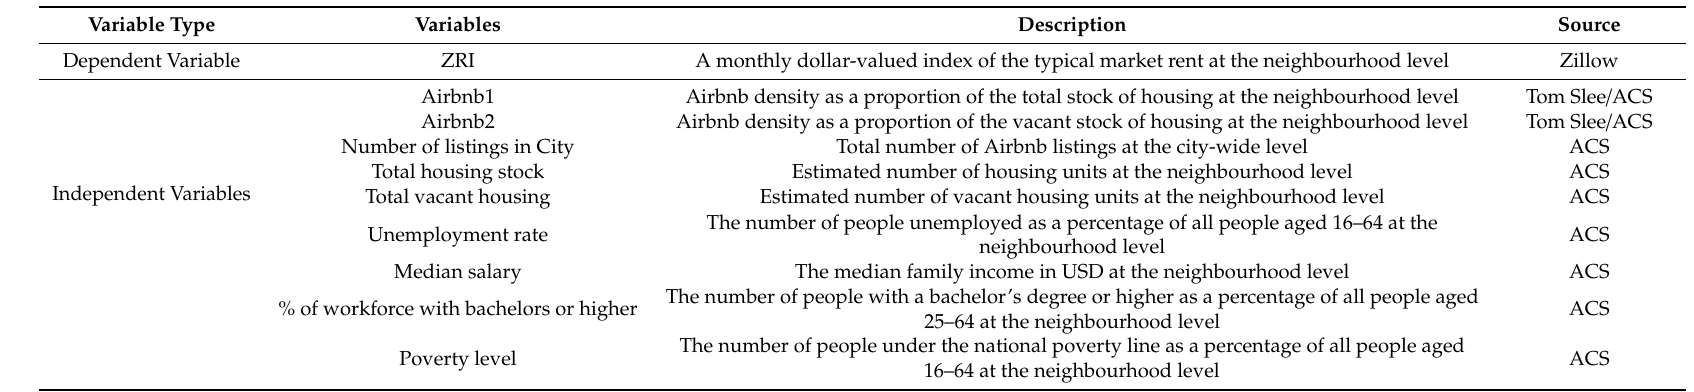
Table 2. Identification and definition of